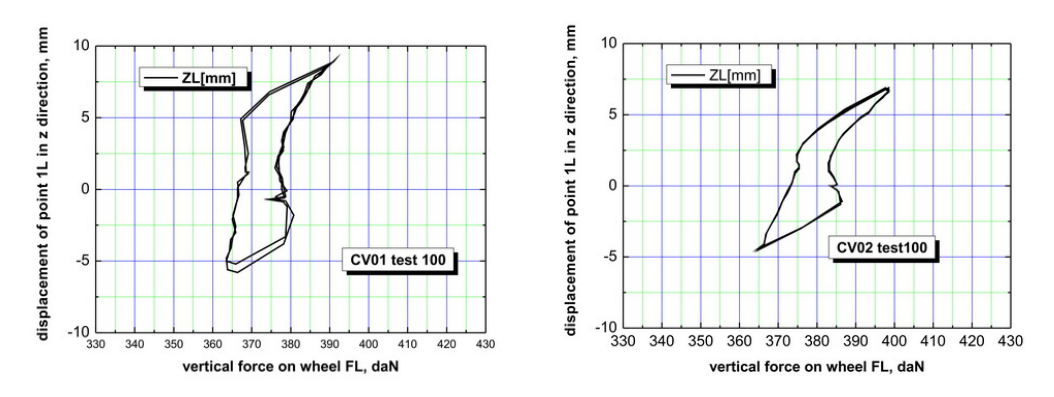
Fig. 5.5. Displacement alterations depending on vertical force during test No. 100.